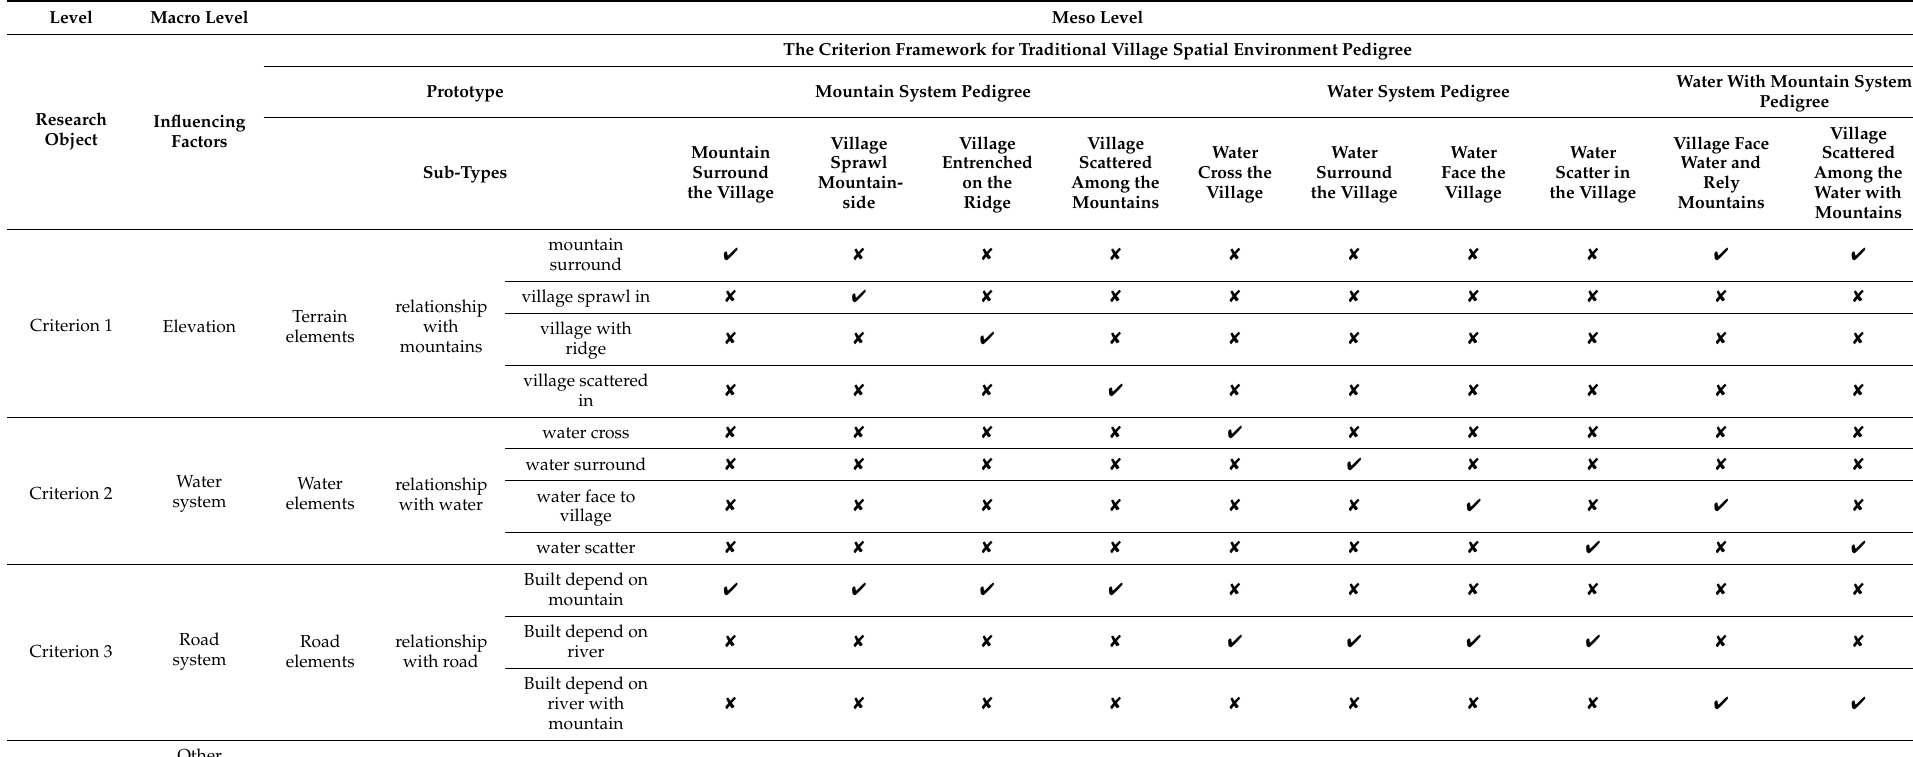
Table A2. The Criterion Framework for Traditional Village Spatial Environment Pedigree: Edited by